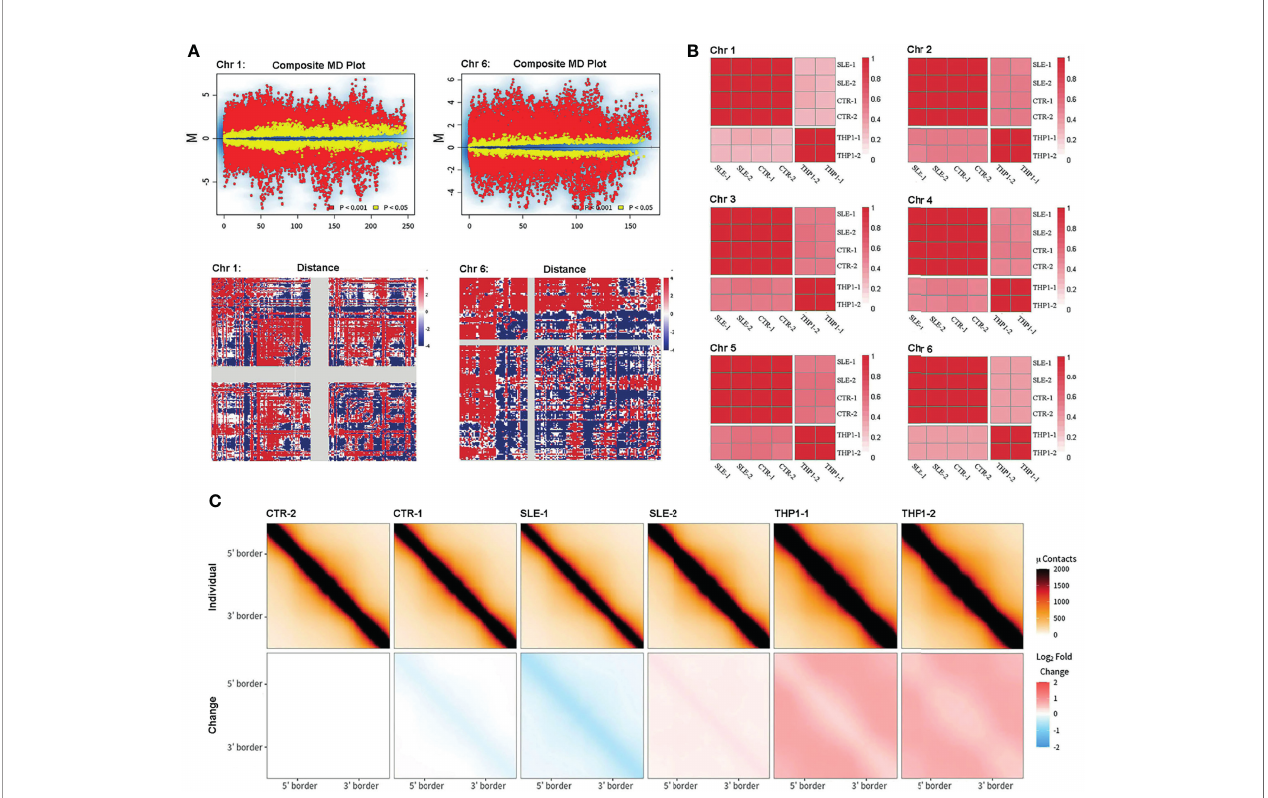
FIGURE 3 | Comparison of Hi-C. Comparison of Hi-C among primary monocytes and THP1 by different methods. (A) The results from multiHiCcompare. The upper part displays the MD plot of comparison between four primary samples and two repeats of THP1, the lower part displays the difference matrix between primary monocytes and THP1. Here the results of chromosome 1 and chromosome 6 are presented. (B) The correlation matrix between the six samples. The pair-wised stratum-adjusted correlation coef fi cients (SCC) are calculated using hicrep package. The results of chromosome 1-6 are presented. (C) The aggregate peak analysis (APA) among the six samples. Here the we set CTR-2 as